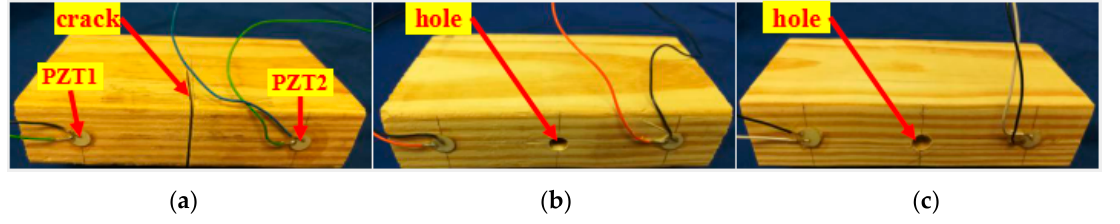
Figure 2. Timber specimens for different groups. ( a ) Specimen of Group A; ( b ) specimen of Group B; ( c ) specimen of Group C.